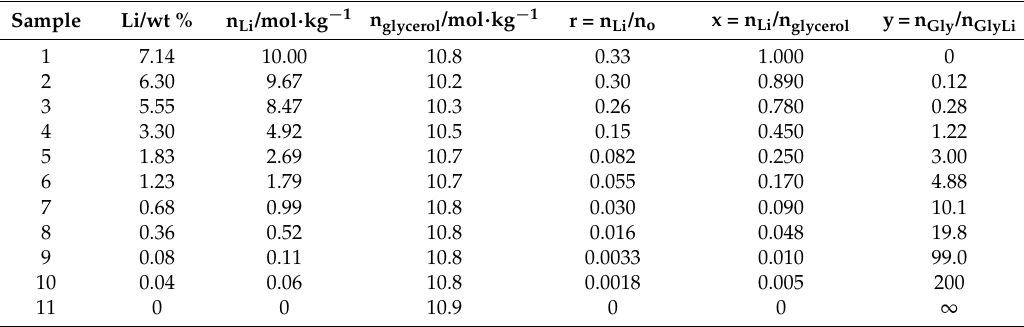
Table 1. Composition of the obtained samples.